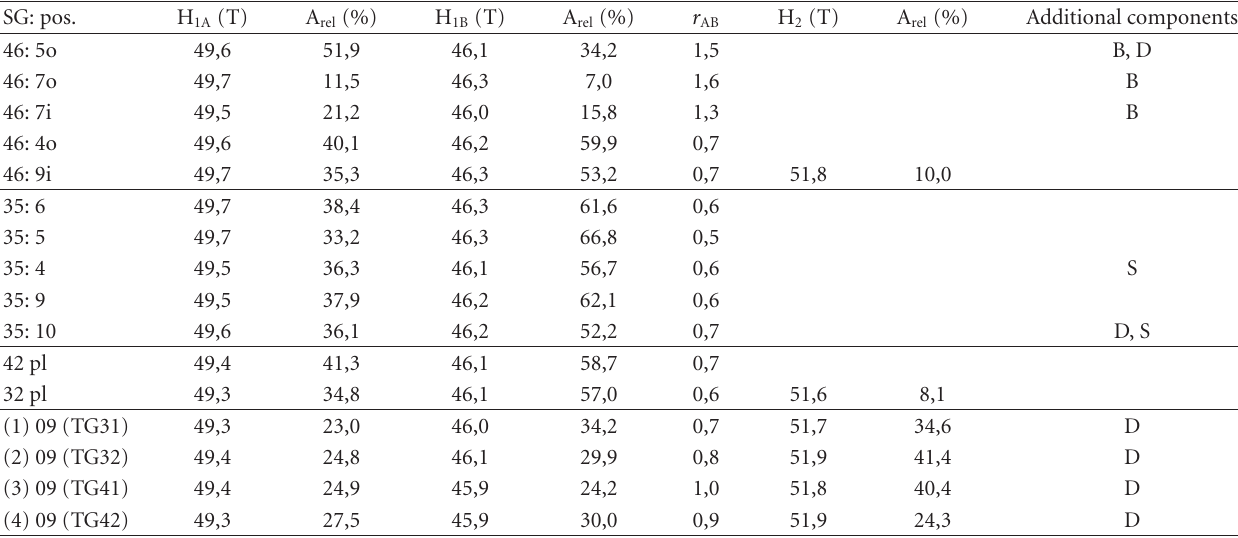
Table 2: MS parameters of corrosion products taken from the steam generators SG46, SG35 and the feed water pipes. SG: pos.